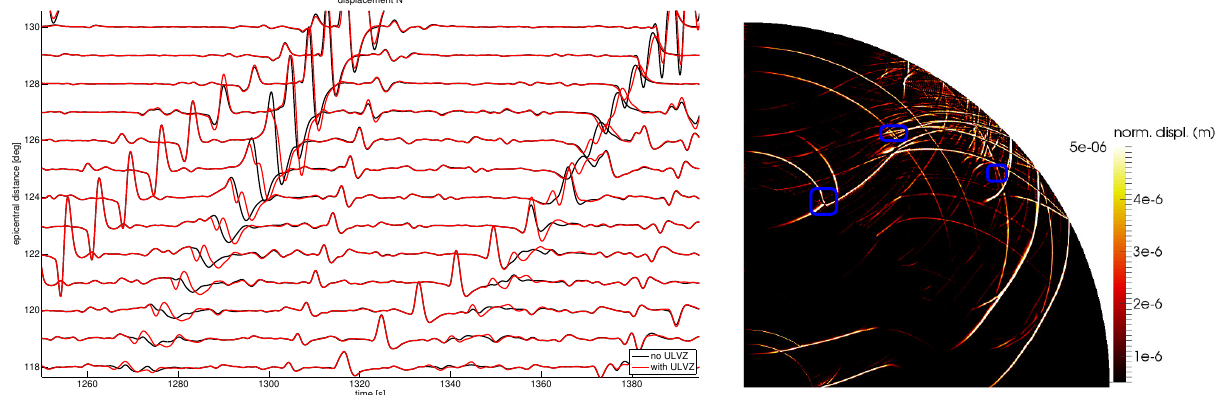
Figure 14. A forensic application of AxiSEM to the in-plane detectability of an azimuthally invariant representation of two adjacent structures: a “ULVZ” near an “LLSVP” (see model in Fig. 10). Left: Seismograms for a model with a ULVZ as in Fig. 10 (red traces), and one exactly the same but without the ULVZ (black traces). The underlying Earth model is the isotropic PREM (Dziewonski and Anderson, 1981), dominant period 2s. The N -displacement record sections are at considerably large epicentral distance ranges. Right: Wavefield snapshot of the same simulation with ULVZ, at time 604s. Blue quadrants denote those parts of the wavefield that are most affected by the presence of the ULVZ (in comparison to a similar plot for the simulation without ULVZ).